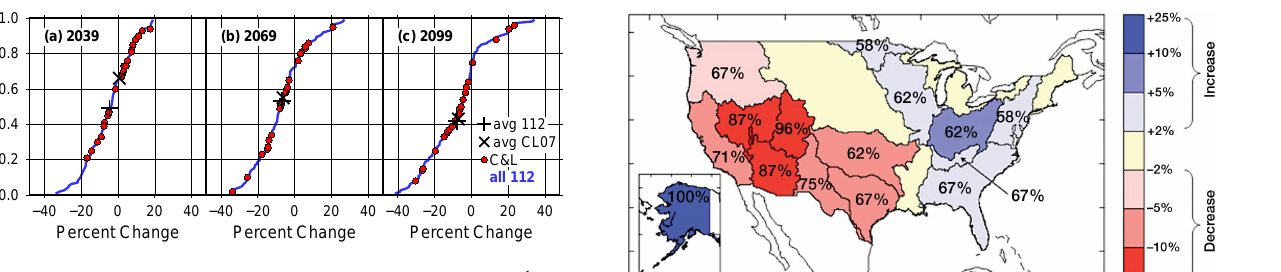
Fig. 11. Distributions of projected changes in 30-yr averages (trail- ing) of annual streamflow from GCMs included in CL07, compared to the distribution for all CMIP3 projections in the LLNL archive (present study).